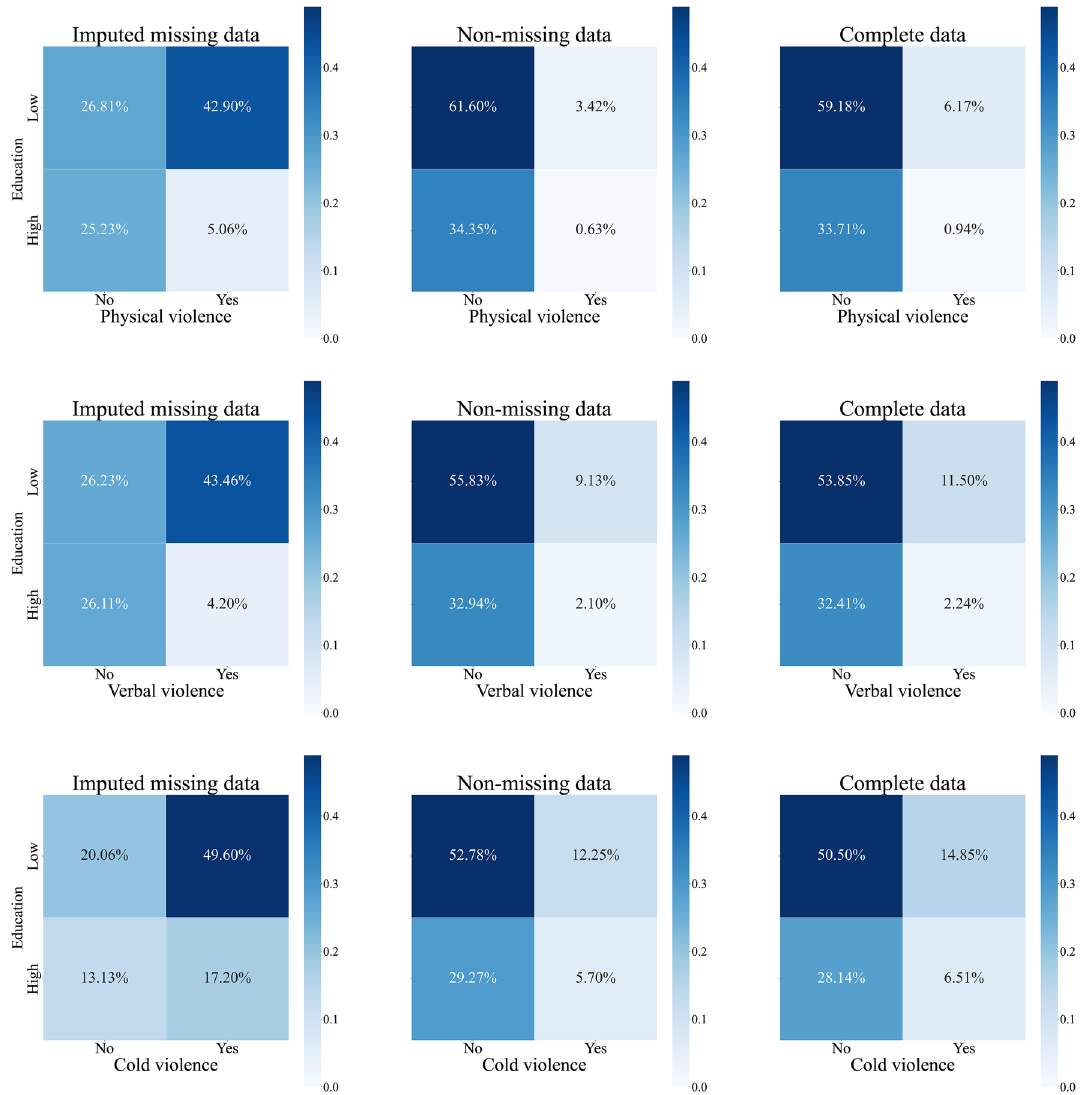
Figure 3. Joint probability distributions of education and IPV. Note Low Junior high school or below, High High school or